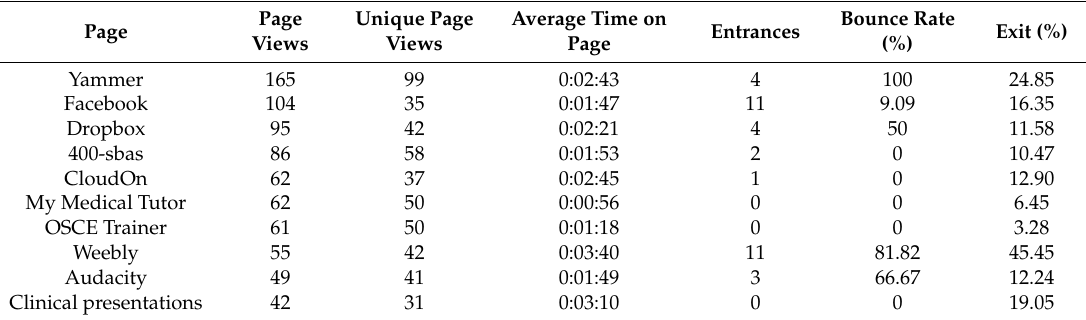
Table 2. Top 10 popularly used digiMe apps identified by Google